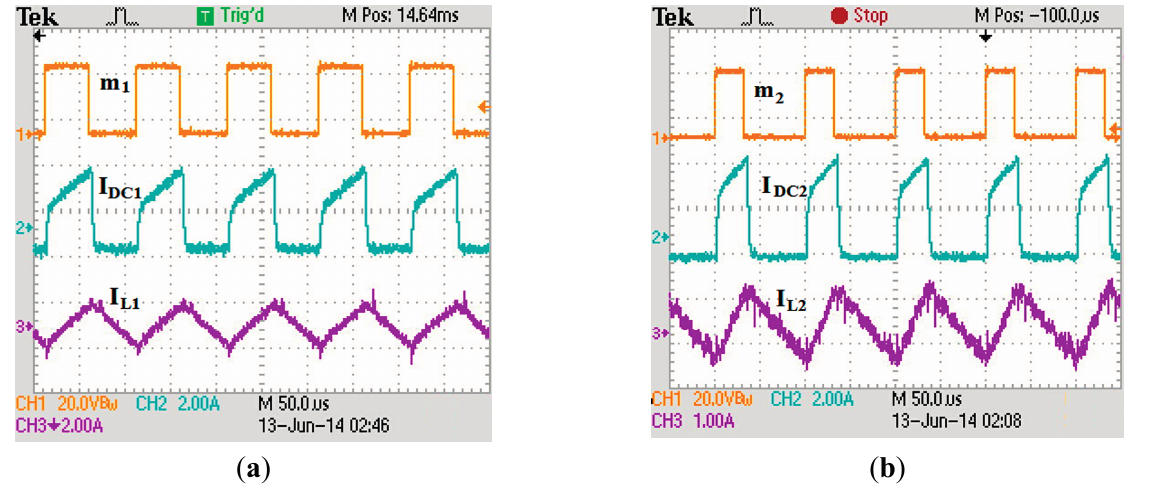
Figure 11. Principal waveforms of the buck converters, ( a ) m 1 , I L 1 and I DC 1 for buck 1 and ( b ) m 2 , I L2 and I DC2 for buck 2 .